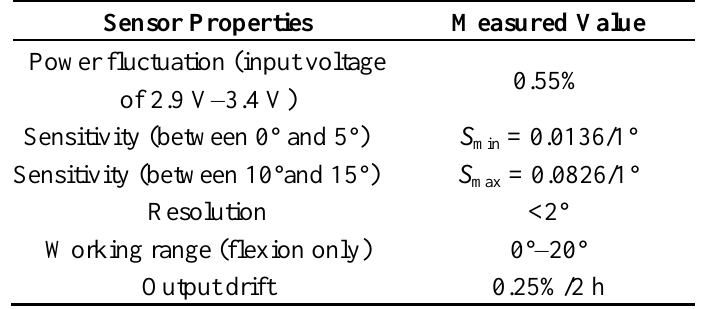
Table 2. Optical fibre bending sensor properties of this